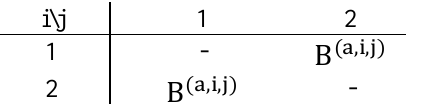
Figure 7. Matrix A for demand pattern from origin “ ” to destination “ ” With this input, the output of the optimization model is the departure time of each barge or rail service and the flow of batches transported by each